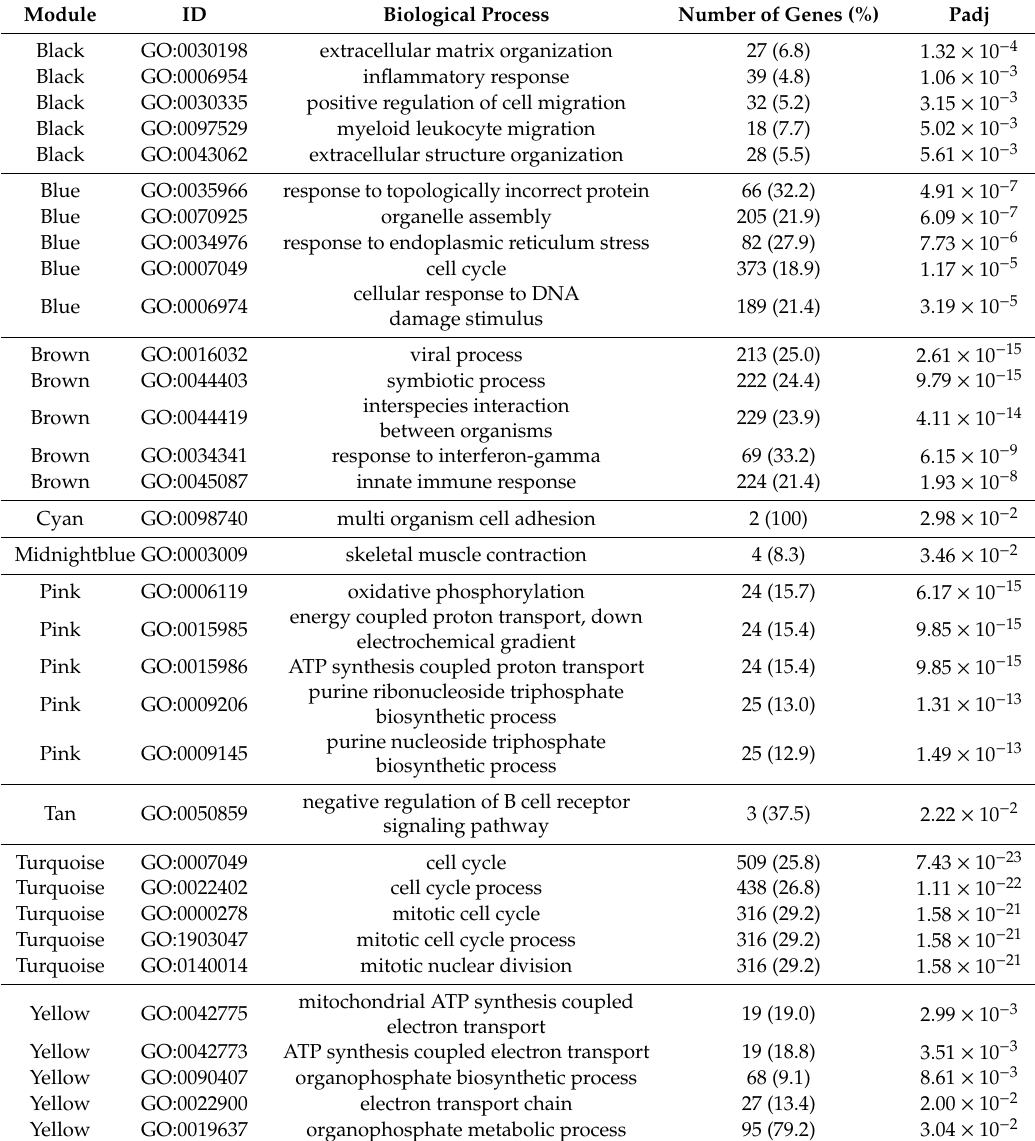
Table 1. Significantly enriched Gene Ontology Biological Process (GO_BP) terms for each module of the WGCNA. Modules not mentioned have no significant enriched term based on the Bonferroni-adjusted p